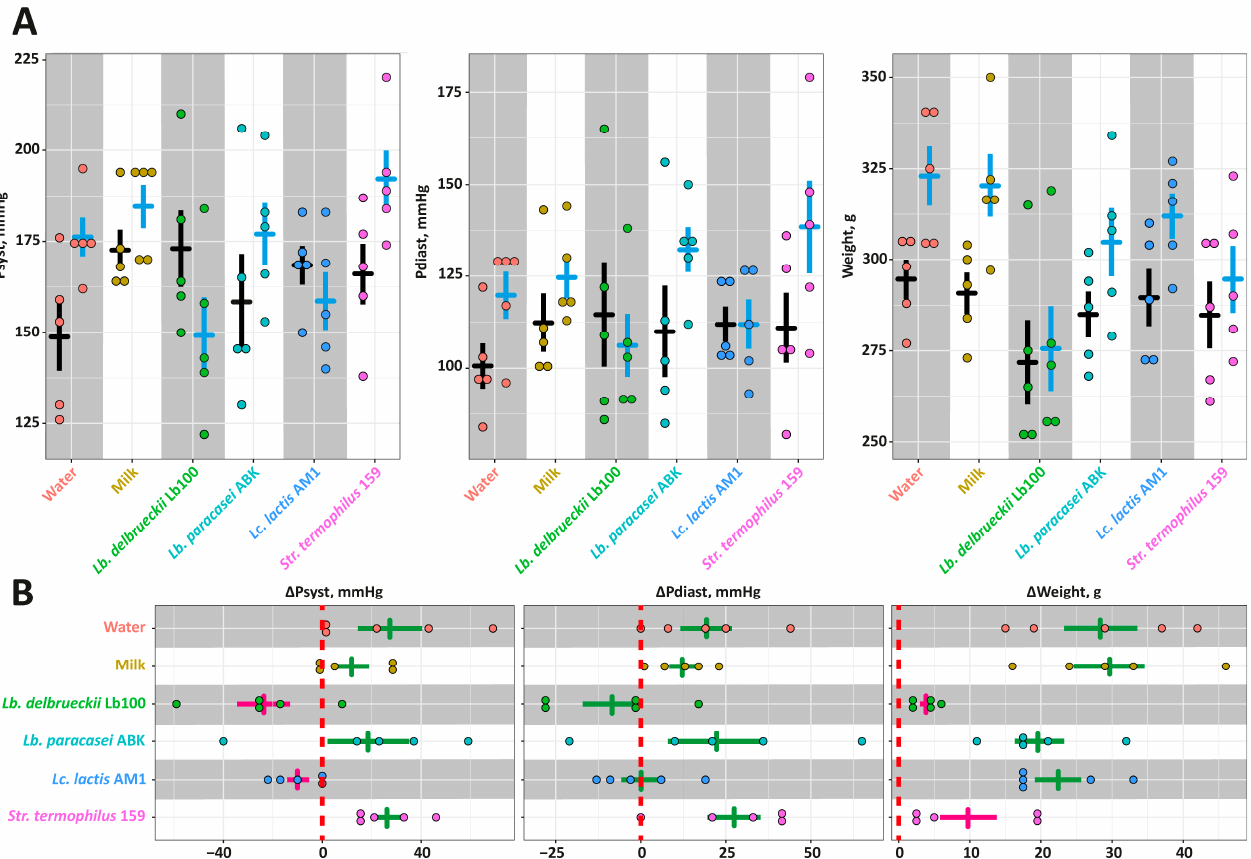
Figure 2. The in vivo assessment of antihypertensive properties for the milk fermented by the chosen strains of lactic acid bacteria using Spontaneously Hypertensive Rat (SHR) animal model: ( A )—the absolute values of the Psyst, Pdias and Weight. The black bars correspond to the Mean ± SE at the beginning of the experiment, and the blue bar correspond to the Mean ± SE at the end (4 weeks) of the experiment; ( B )—the changes of the Psyst, Pdias and Weight. The bars (Mean ± SE) for the groups between which no statistically-significant differences were detected are depicted in the same color.